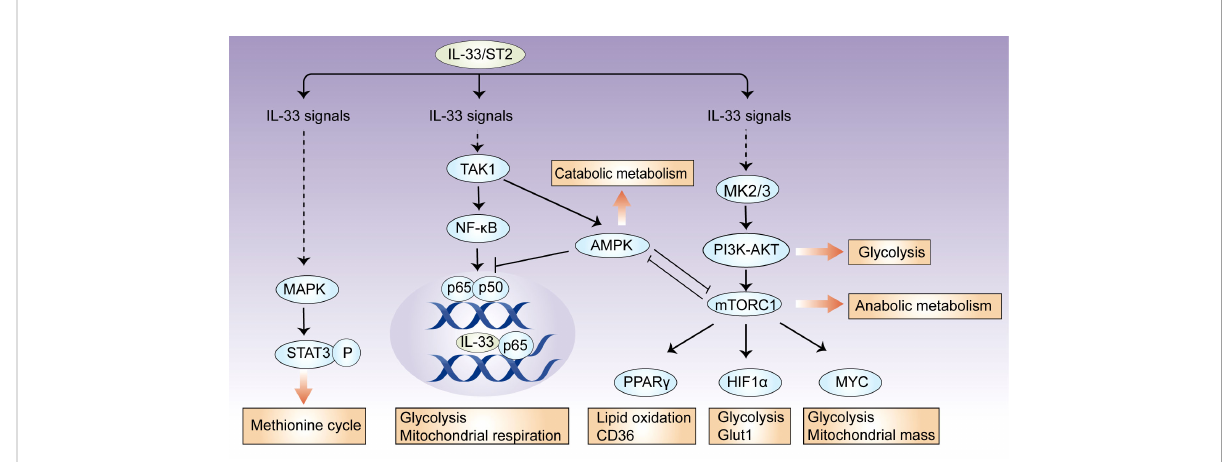
FIGURE 1 IL-33 controls metabolic checkpoints in immune cells. There are several metabolic checkpoints by which IL-33 can participate in cellular metabolism. IL-33 activates the metabolic regulators mTORC1, PI3K-AKT, and AMPK, which coordinately in fl uence downstream effector molecules, such as HIF- 1 a , Myc, and PPAR g , and subsequently orchestrate glycolytic and lipogenic programs. In this process, AMPK suppresses IL-33-induced NF- k B activation; intracellular IL-33 can also bind to NF- k B p65 and restricts its transcriptional activity, suggesting that a feedback loop controls cellular metabolic homeostasis. Additionally, IL-33 activates mitochondrial STAT3 via MAPK and fuels the methionine